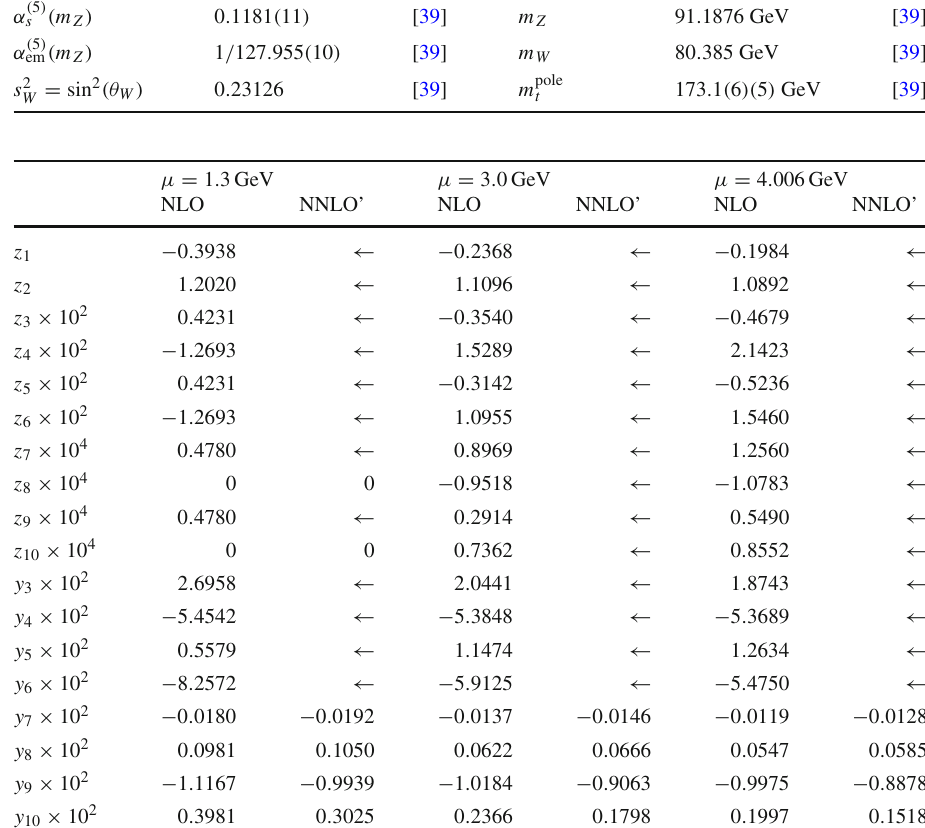
Table 6 Numerical input for Wilson coefficients